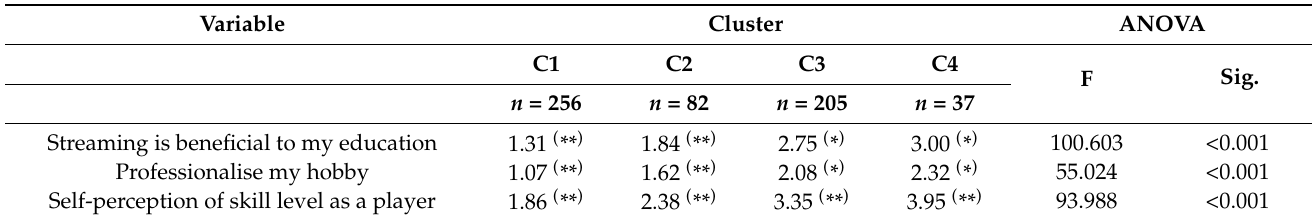
Table 5. Characterisation of the three perception